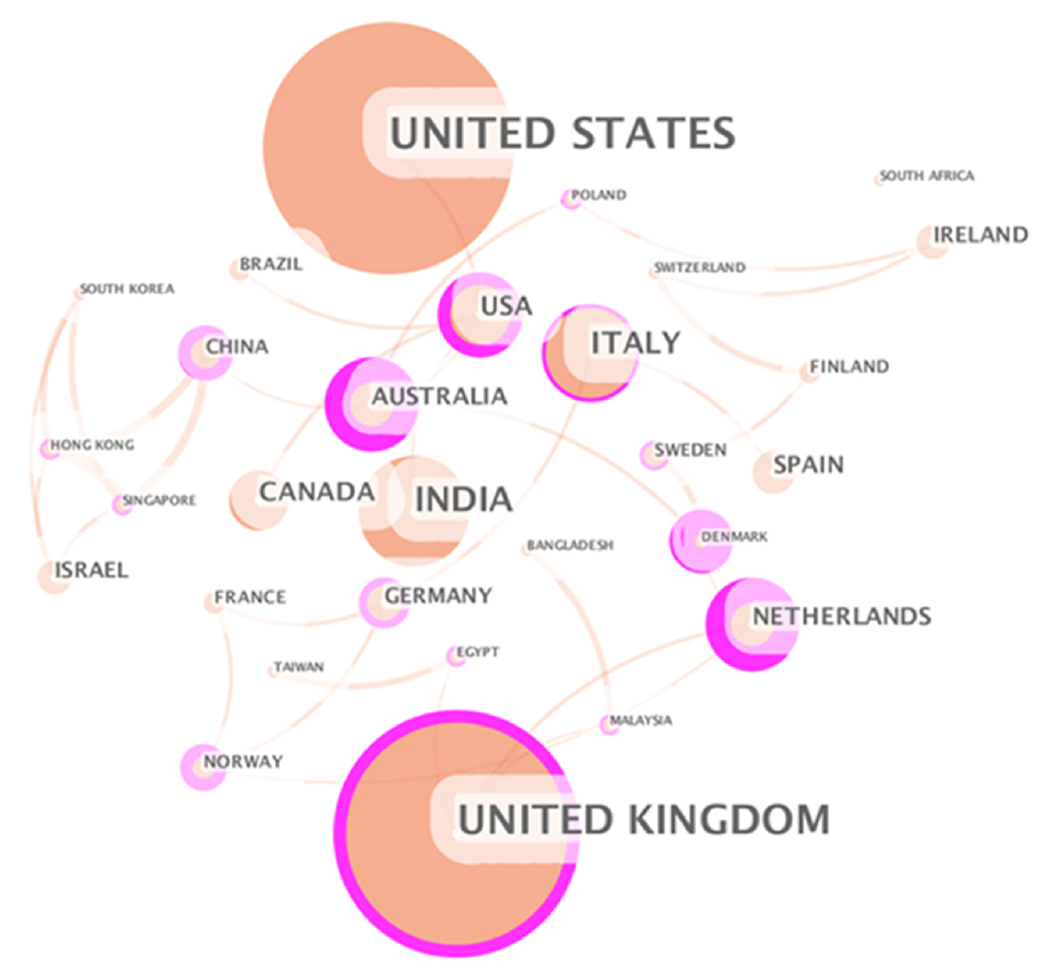
Figure 10. The cooperation network of countries.